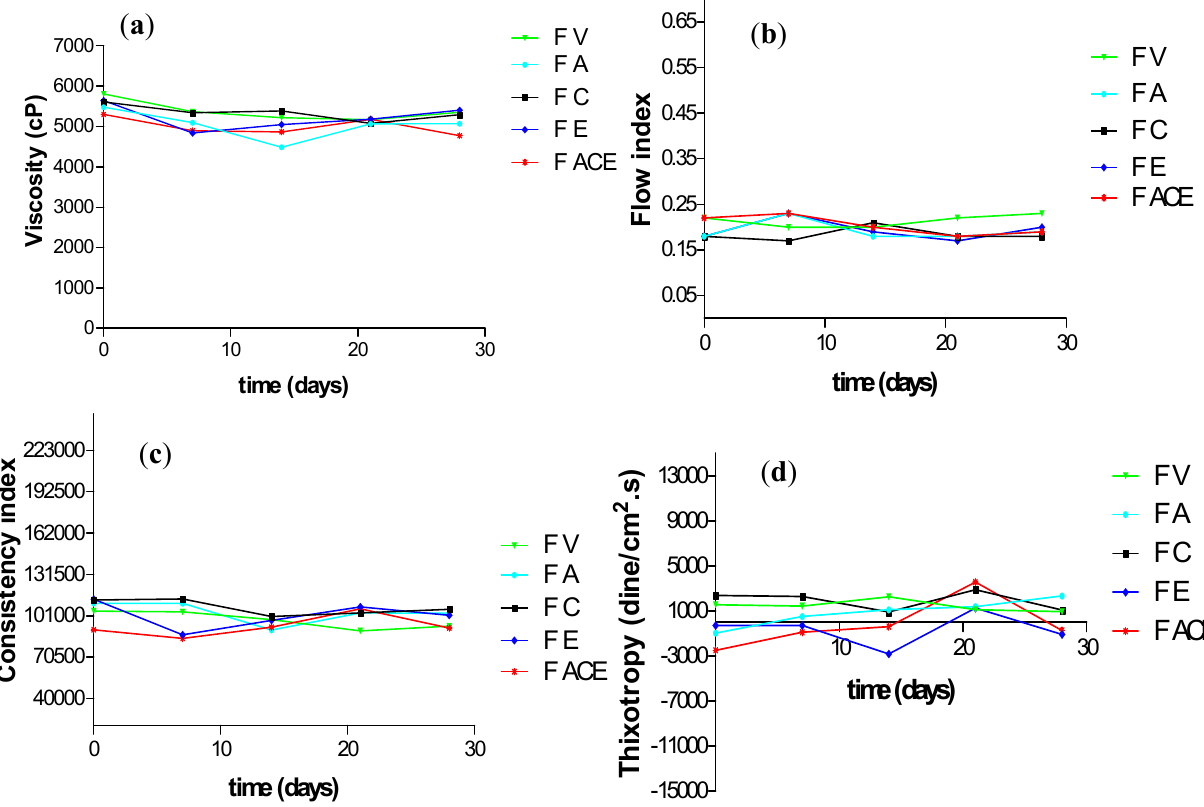
Figure 2. Alterations in the apparent viscosity ( a ), flow index ( b ), consistency index ( c ) and thixotropy ( d ) of vehicle (F V), or the vehicle supplemented with vitamin A (FA), vitamin C (FC), vitamin E (FE) or with the combination of these vitamins (F ACE) initially (0), 7, 14, 21 and 28 days after preparation, at room